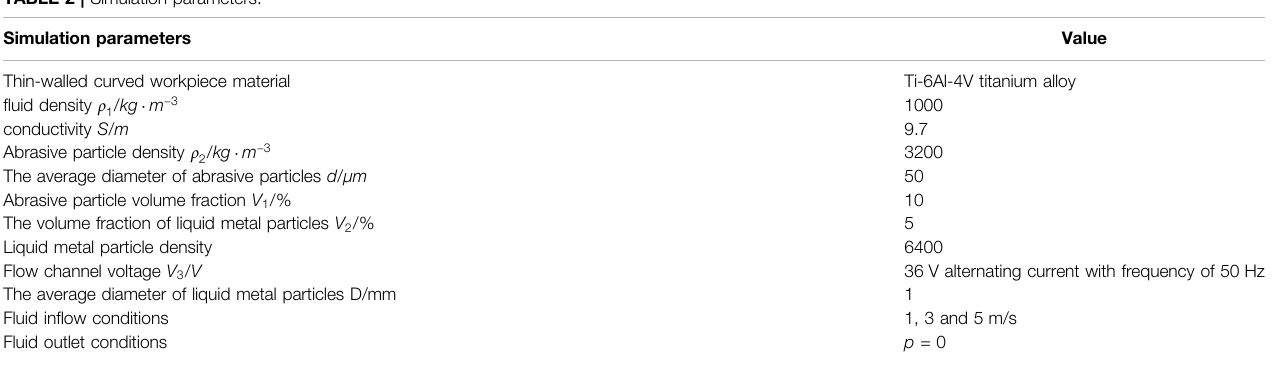
TABLE 2 | Simulation